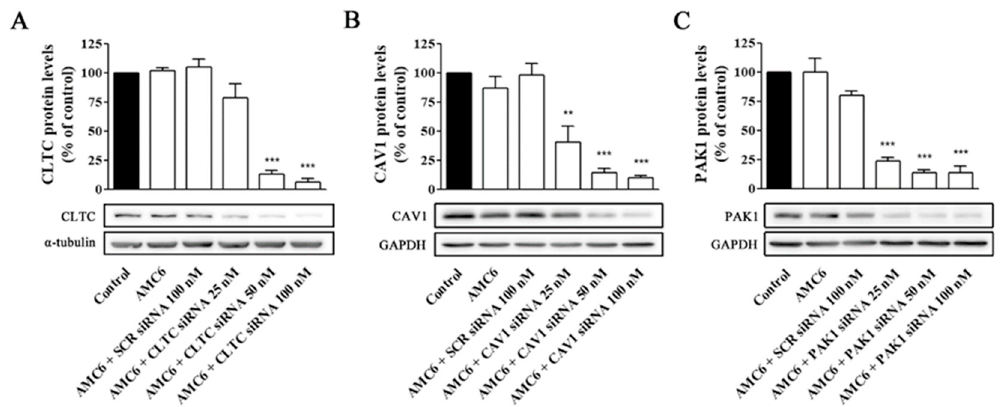
Figure 4. Knockdown of CLTC, CAV1 and PAK1 proteins by specific siRNAs. Cells were treated for 72 h with vehicle (Control), AMC6 (1 µ M), AMC6 (1 µ M) complexed with SCR siRNA (100 nM) or AMC6 (1 µ M) complexed to increasing concentrations of specific siRNAs (25, 50 and 100 nM). The graph shows the ratios between the optical densities of CLTC and α -tubulin ( A ), CAV1 and glyceraldehyde 3-phosphate dehydrogenase (GAPDH) ( B ) and PAK1 and GAPDH ( C ), expressed as percentage in comparison to the vehicle (control). Western blot images belong to a representative experiment. Data are expressed as the mean ± SEM of 3 individual experiments. ** p < 0.01; *** p < 0.001 as compared to control.